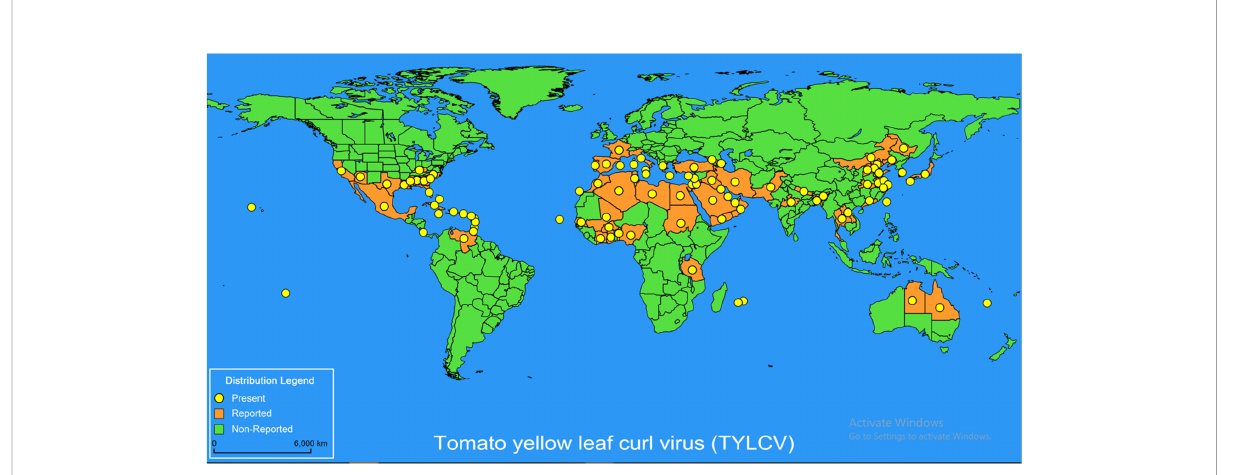
FIGURE 1 The distribution of Tomato yellow leaf curl virus (TYLCV) globally. The global distribution of TYLCV disease is updated by the EPPO Global Database (19 November 2021). The yellow marks indicate present infection, the orange marks indicate reported condition, and the green marks indicate non-reported